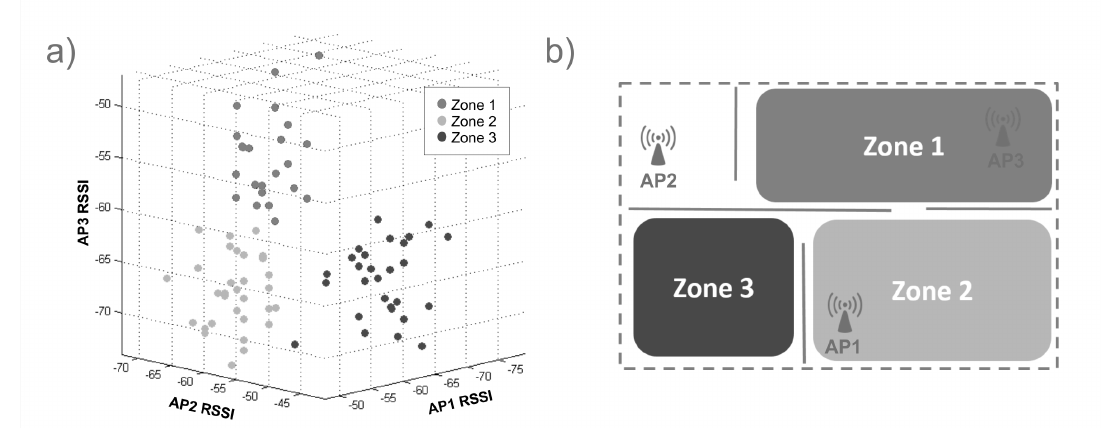
Figure 1. ( a ) 3D radio-map plot of RSSI data collected; ( b ) an example map of three zones and three access points